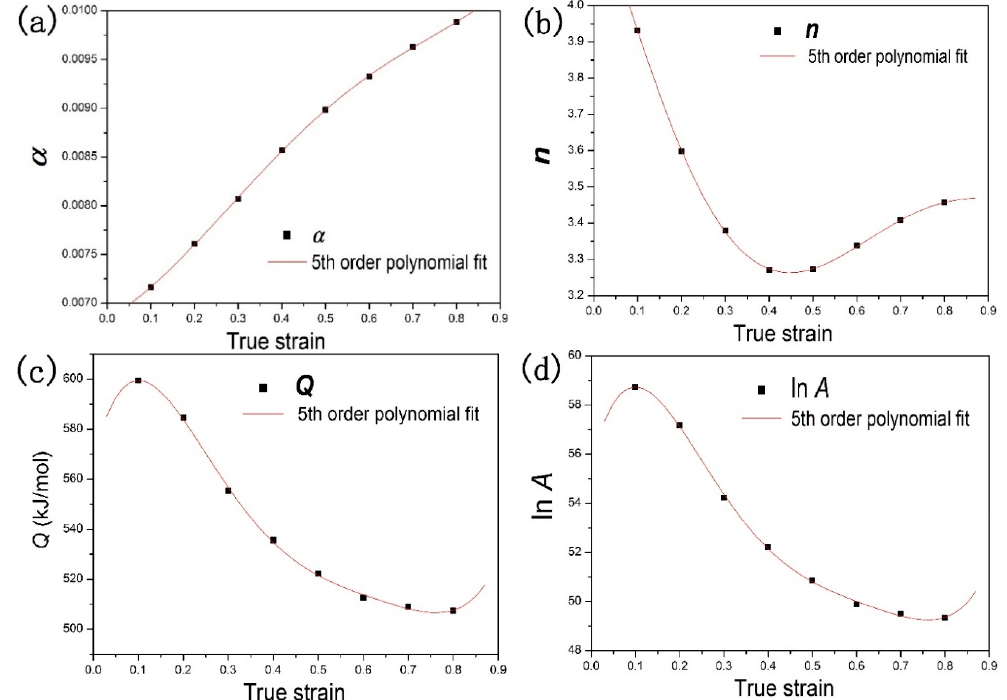
Figure 8. The variation with strain of the material constants: ( a ) α , ( b ) n , ( c ) Q , and ( d ) ln A .